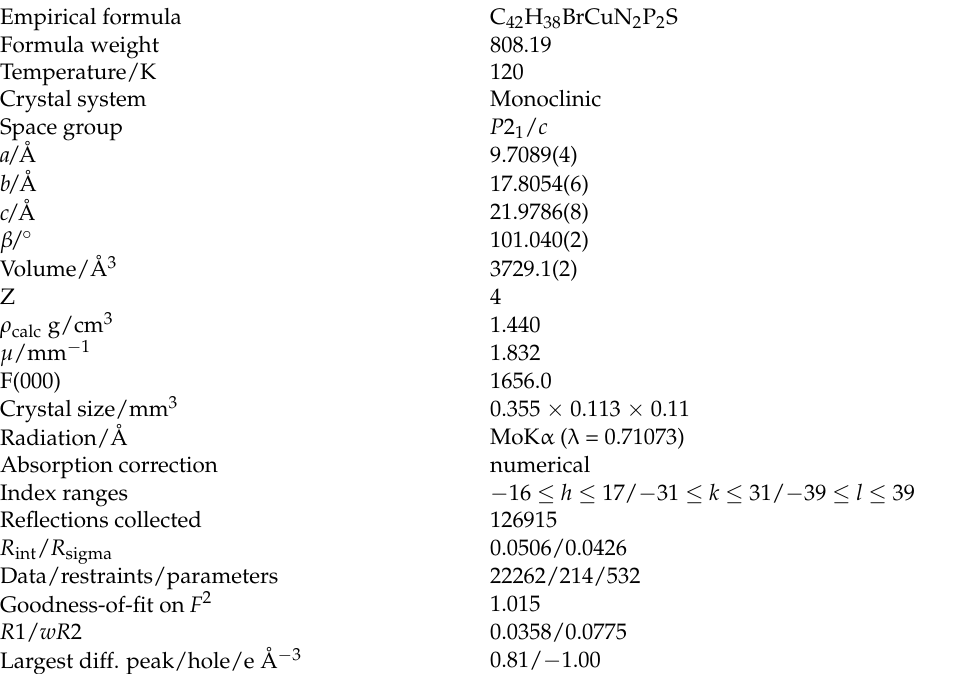
Table 1. Crystal data and structure refinement for [CuBr(C 18 H 15 P) 2 (C 6 H 8 N 2 S)]. Empirical